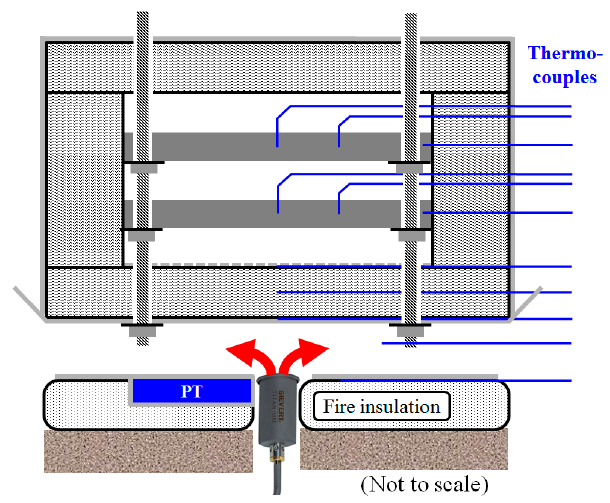
Figure 5. Sketch of mockup including propane gas burner, type K mantle thermocouples, flush